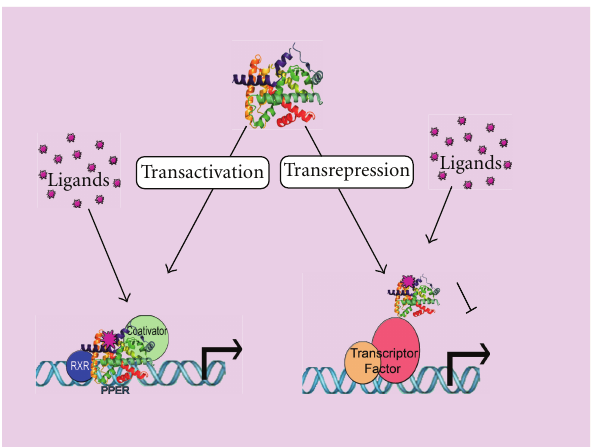
Figure 1: Basic mechanism of PPAR action. Receptor X retinoide, RXR; PPAR-response element,